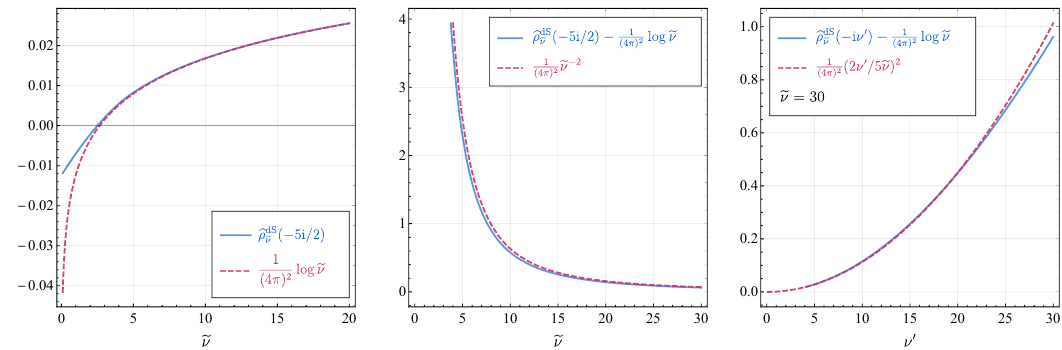
( − i ν 0 ) in (B.43) and its approximations in the ρ dS b e ν ν = 30 e